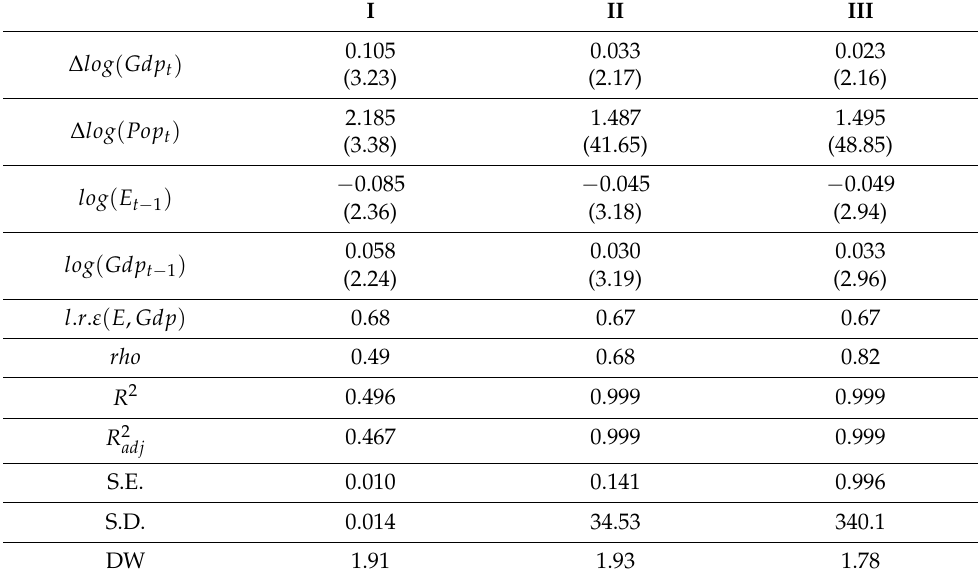
Table A1. Estimation results.